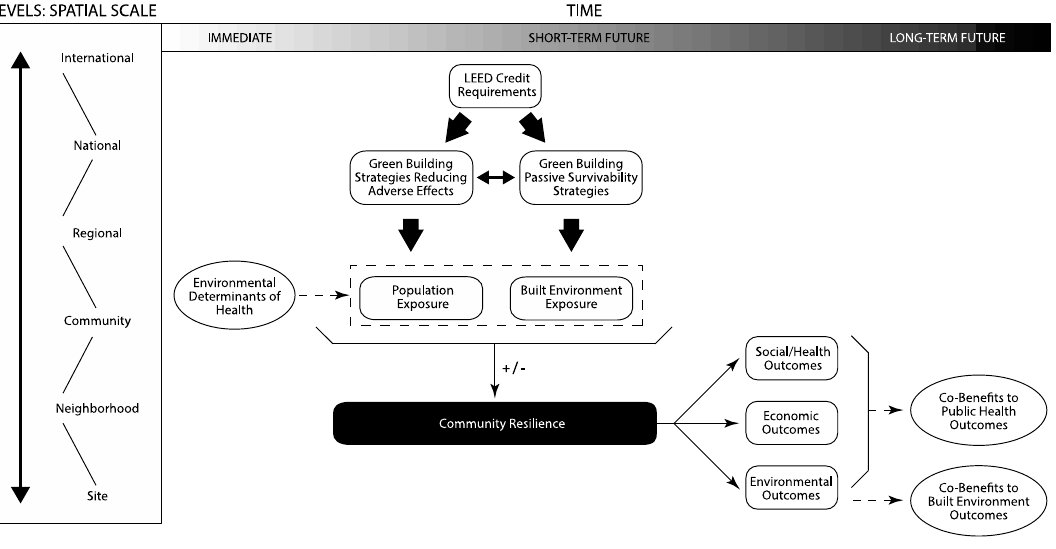
Figure 1. Conceptual framework: establishing an evidence base for associations between LEED credit requirements and climate change resilience outcomes.